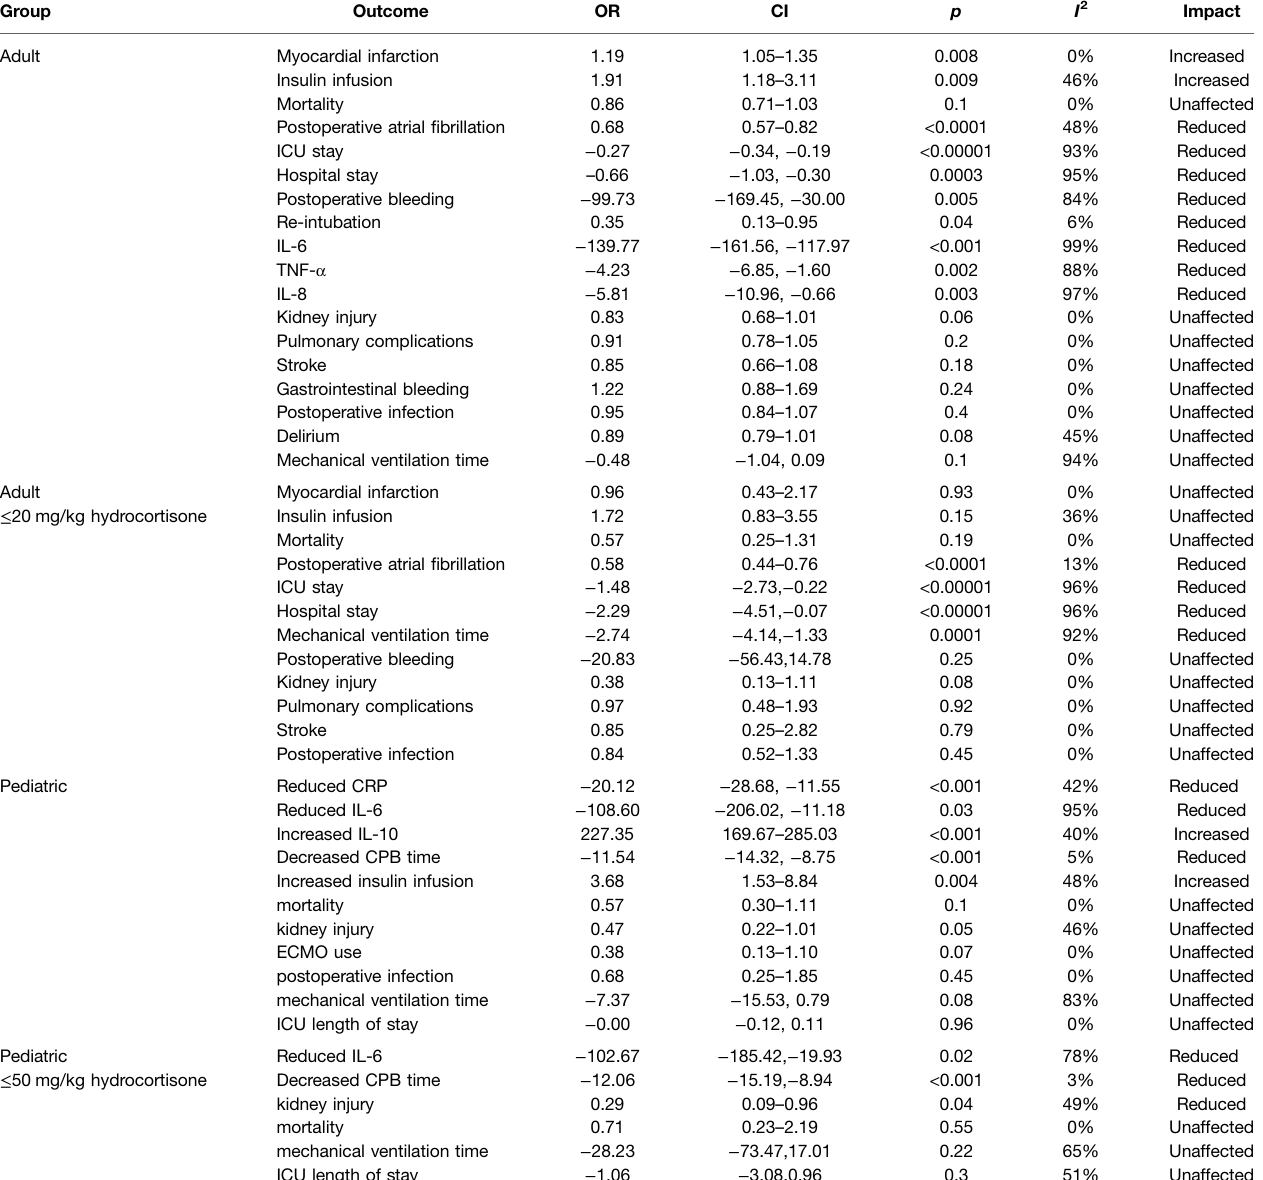
TABLE 3 | Summary of corticosteroids impact on adults and pediatric.